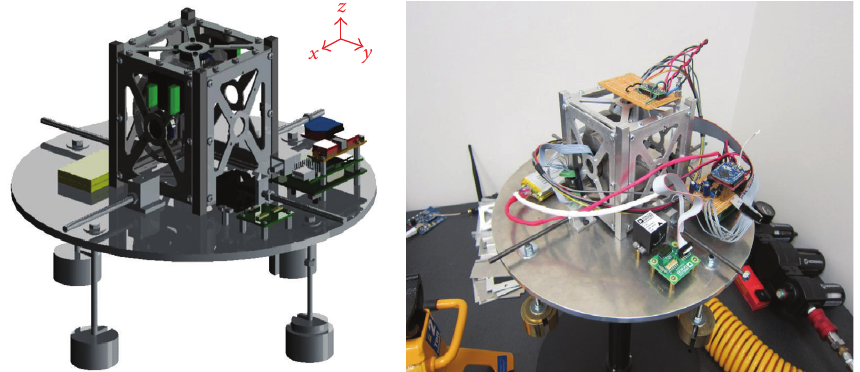
Figure 15: Air-bearing ACS ground testing